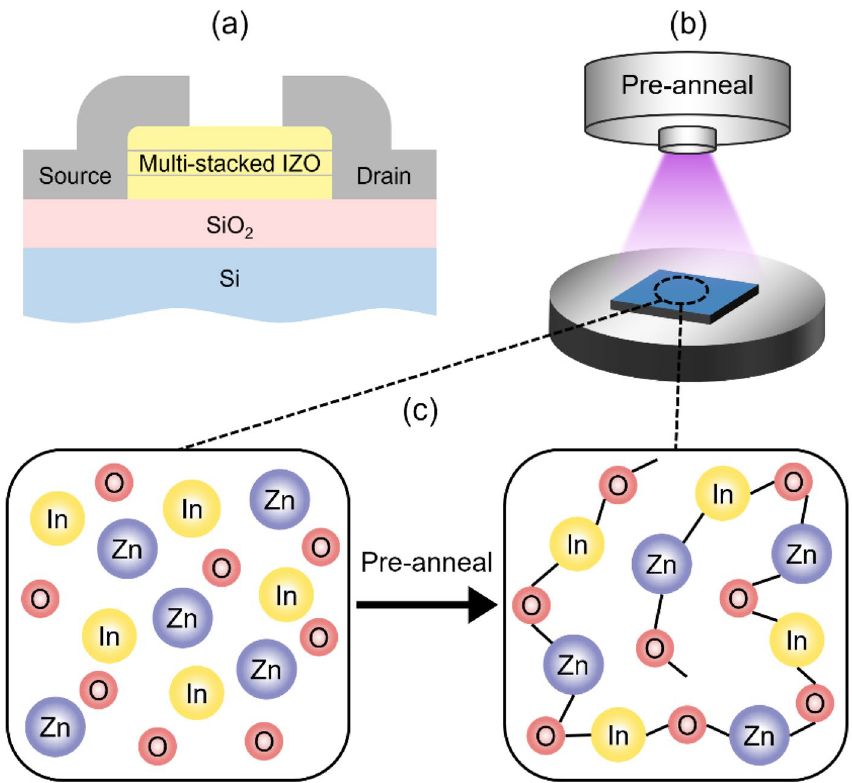
Figure 1. ( a ) Schematic diagram of the device fabrication process for multi-stacked IZO TFTs. Sketches of ( b ) plasma and ( c ) femtosecond laser